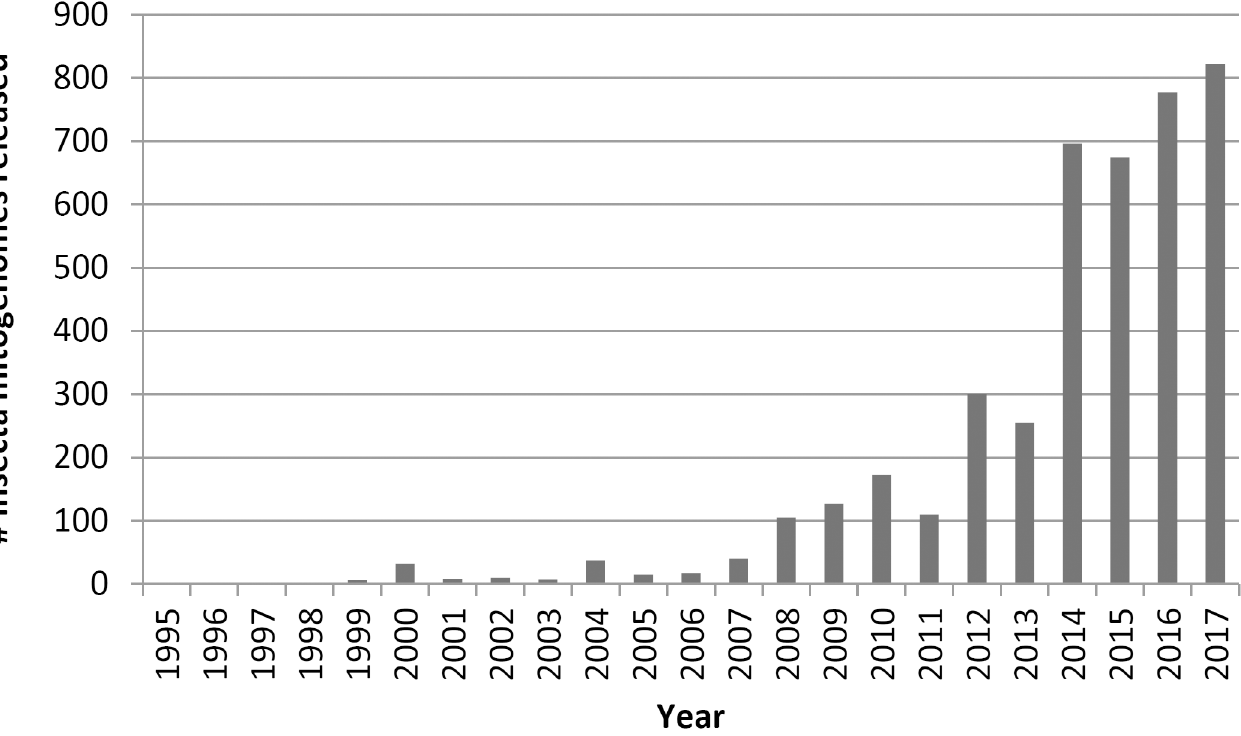
Fig 1. Releaseof Insecta mitogenome sequences in GenBank since 1995 (2017 covers only the first three months of the year). This information was obtainedby searching insecta[organism] AND mitochondrion[ti] AND genome[ti] in the Nucleotidedatabaseand filtering the results by release date by using the "Releasedate" search criterion in the left navigation panel.